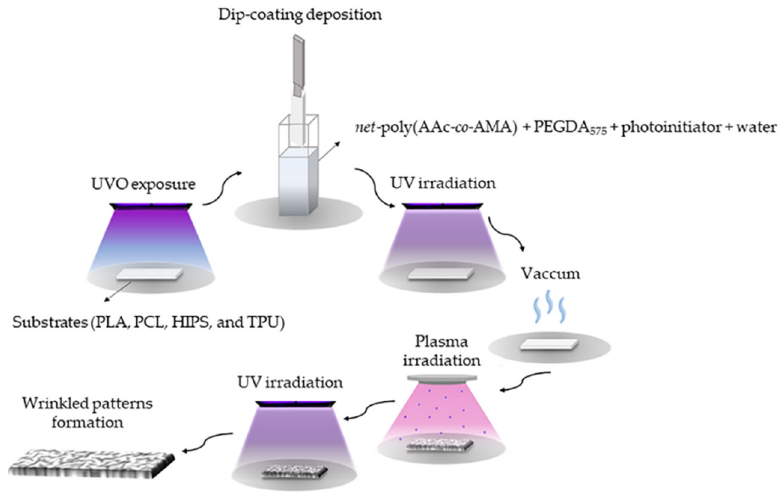
Figure 1. Procedure to generate wrinkled patterns on substrate obtained via FDM technique.